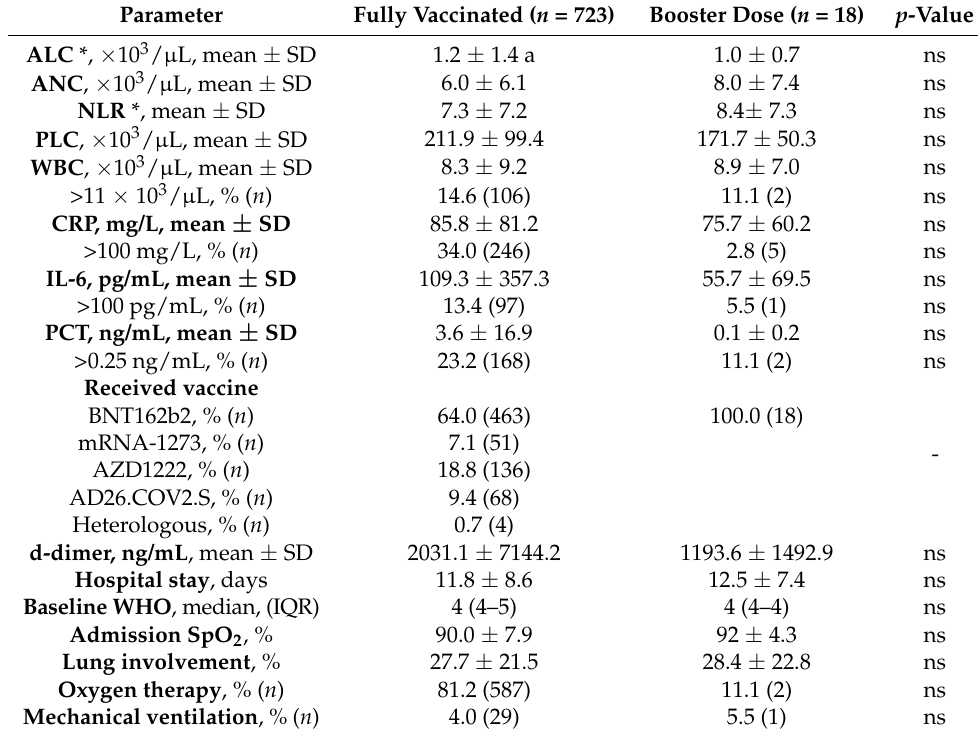
Table 2. Laboratory parameters (mean ± SD) at admission and clinical characteristics of vaccinated patients hospitalized with